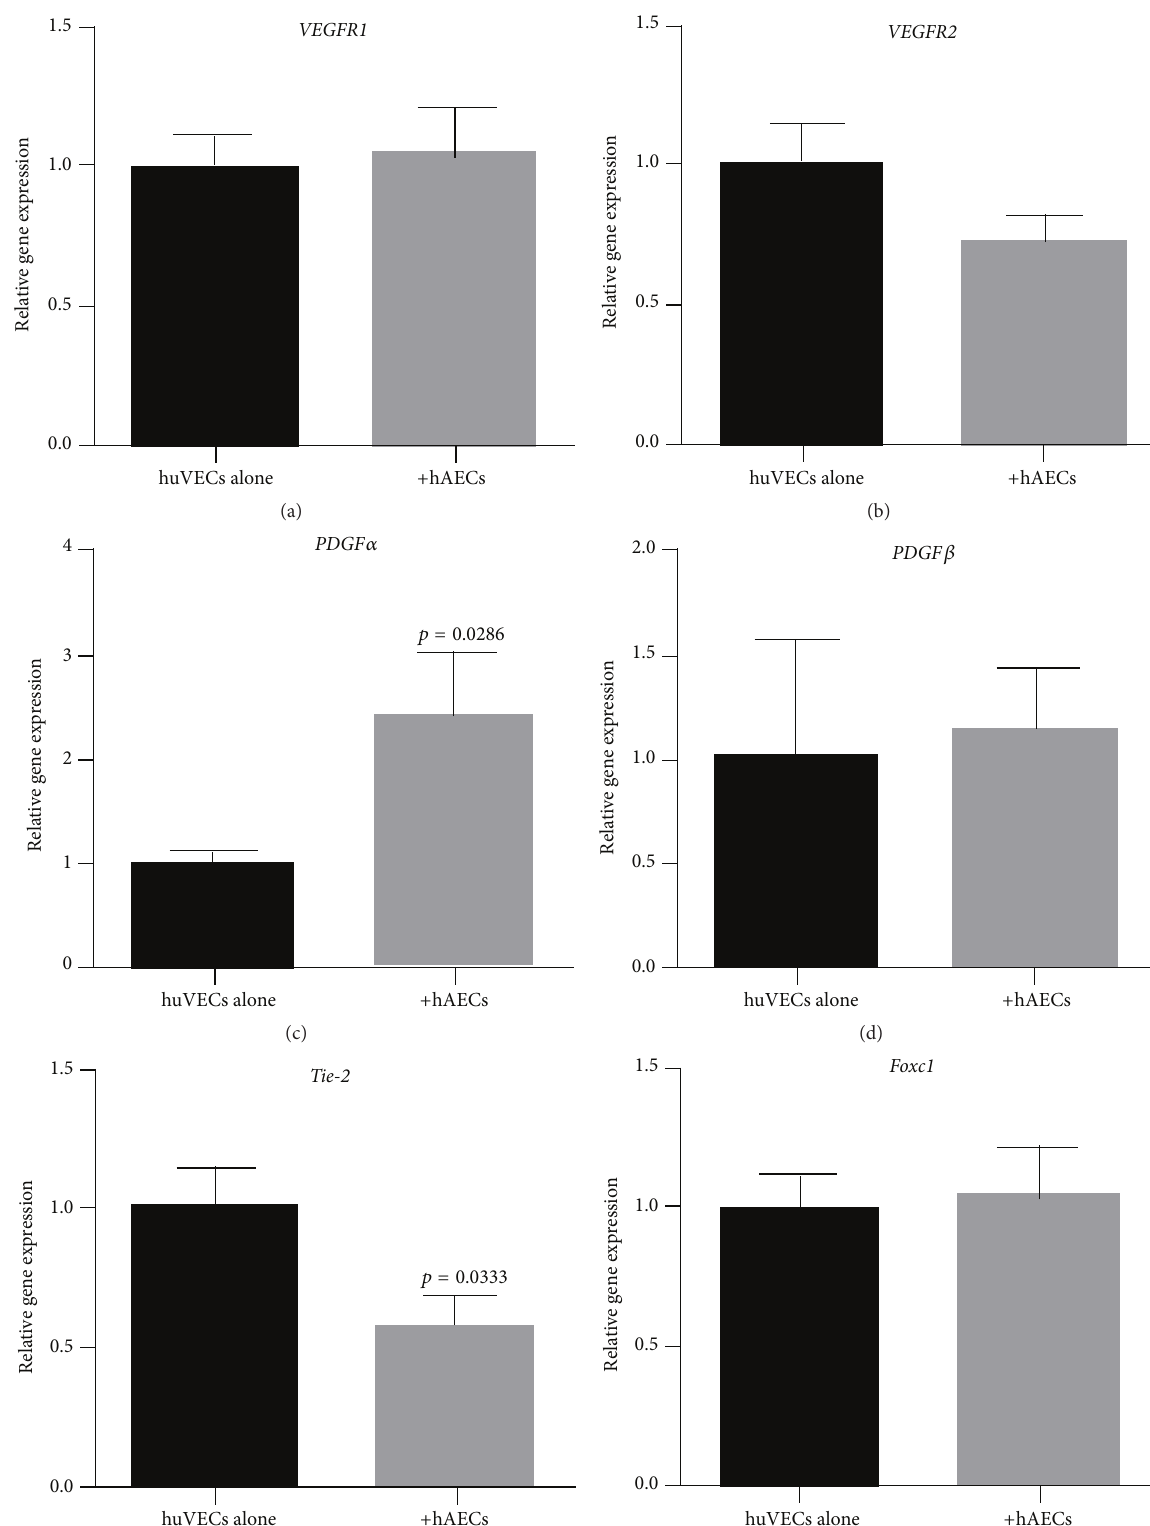
Figure 3: Gene expression of angiogenic factors by huVECs cocultured with term hAECs under basal conditions. ((a)–(f)) huVECs expressed VEGFR1 , VEGFR2 , PDGFR 𝛼 , PDGFR 𝛽 , Tie-2, and FOCX1. Following coculture with term hAECs, ((c) and (e)) gene expression of PDGFR 𝛼 increased ( 𝑝 = 0.0286 ), but gene expression of Tie-2 decreased ( 𝑝 = 0.0333 ), ((a), (b), (d), and (f)) while there was no change in gene expression of VEGFR1 , VEGFR2 , PDGFR 𝛽 , and FOXC1